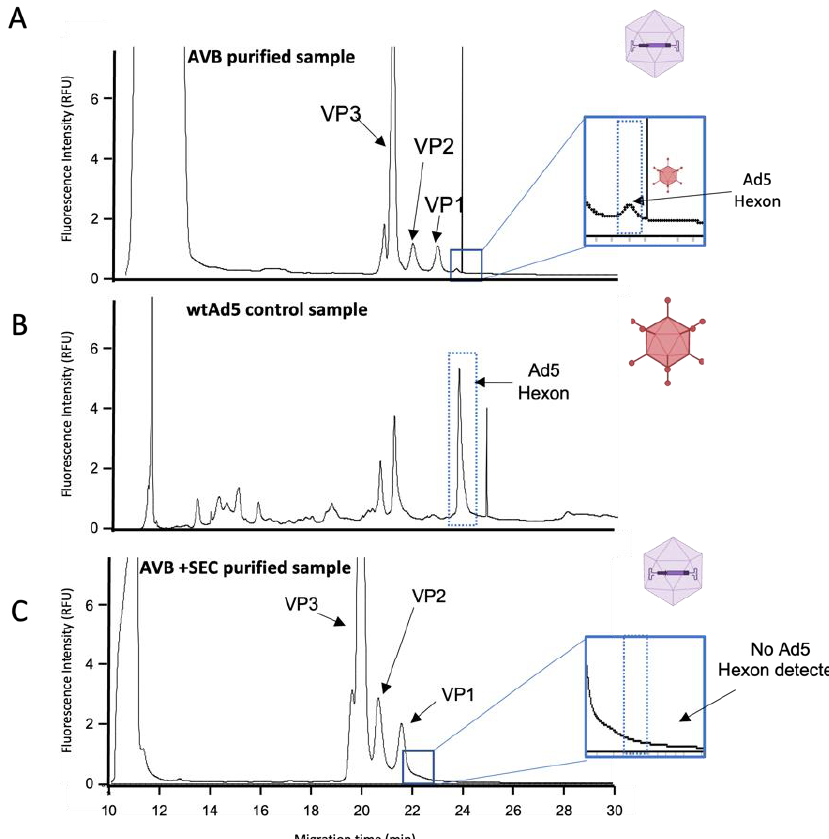
Figure 4. Evaluation of different in-process rAAV samples by CE-SDS LIF. ( A ) Electropherogram of a purified rAAV2 sample with AVB column. ( B ) Electropherogram of wild-type Ad5 control. ( C ) Electropherogram of a purified rAAV2 sample with sequential AVB and SEC columns.